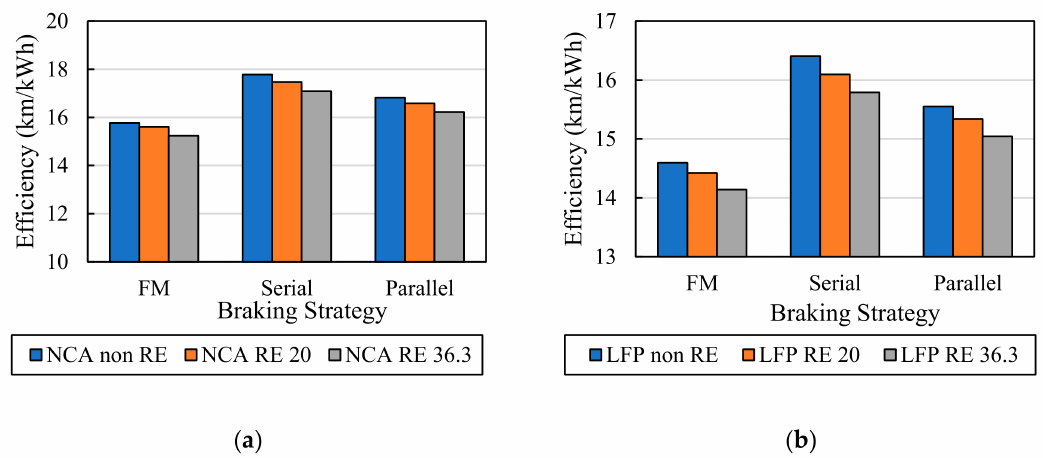
Figure 16. E ffi ciency comparison of RE usage in ( a ) NCA and ( b ) LFP battery configuration for the complete